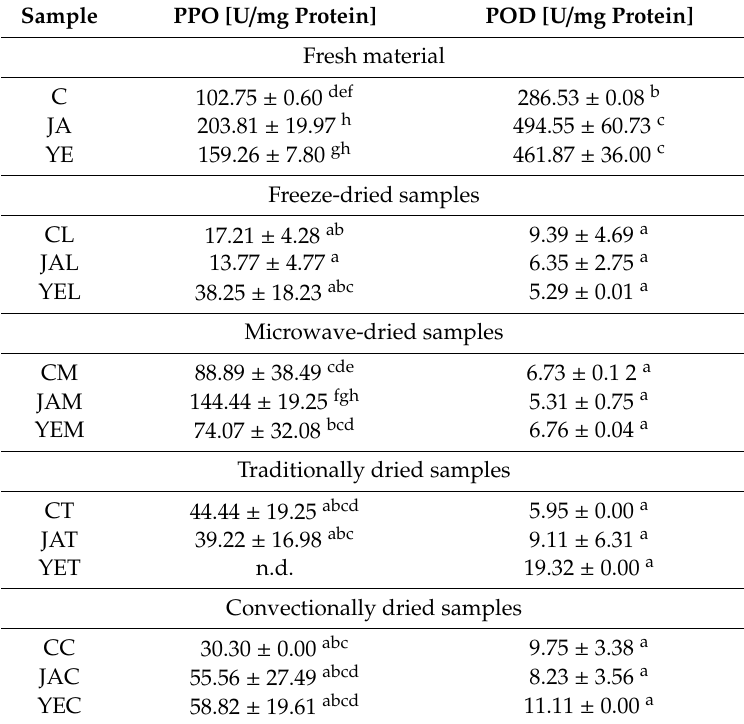
Table 5. E ff ect of elicitation and drying method on the specific activity of enzymes responsible for consumer quality of